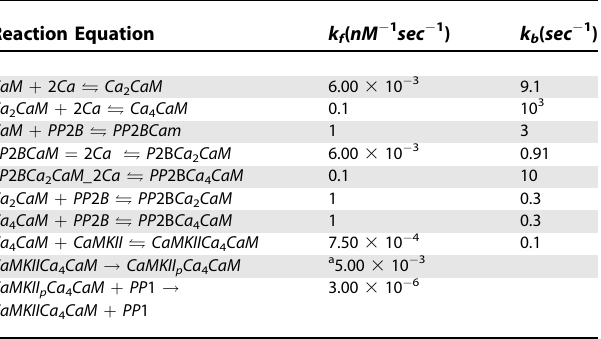
Table 2. Reactions and Rate Constants of Ca to CaMKII and PP2B Pathway Reaction